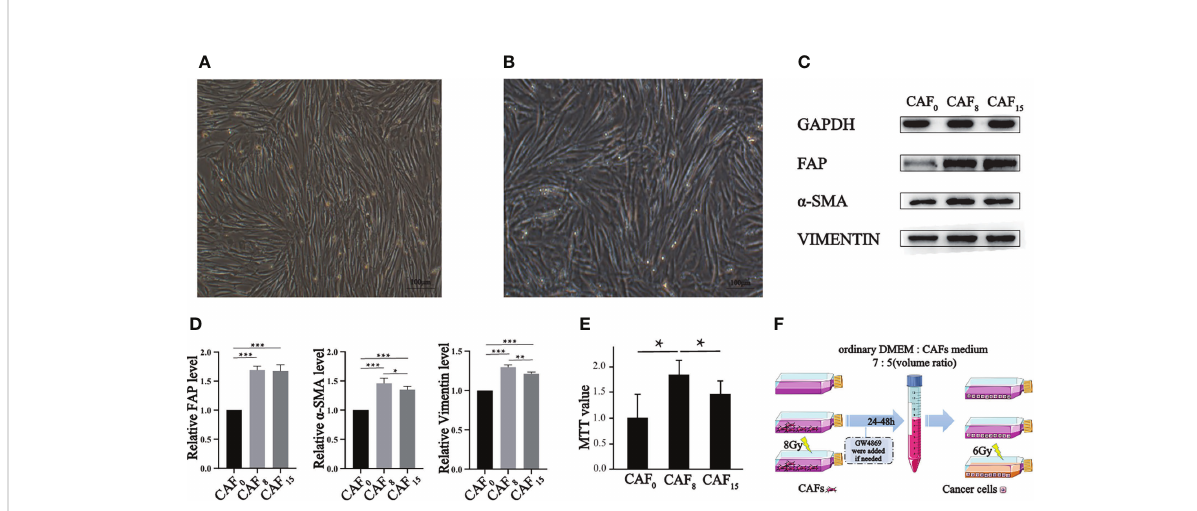
FIGURE 1 Effect of irradiation on the morphology, molecular markers, and proliferation of CAFs. (A, B) Morphology of CAFs without irradiation (A) and CAFs that received 8Gy irradiation (B) were compared under a light microscope (100×), and both groups of cells were spindle-shaped, but the irradiated cells were slightly disorganized; (C) Representative western blotting for FAP, a -SMA, and vimentin in CAFs that received 0Gy, 8Gy, and 15Gy irradiation; (D) The relative expression differences of the biomarkers after normalization of the GAPDH were analyzed by quantitatively comparing the density differences of the immunoblot bands; (E) MTT experiment was used to analyze the proliferation activity of CAFs under 0Gy, 8Gy, and 15Gy irradiation. T-test, * P < 0.05; (F) The sketch map of supernatants preparations of CAFs. (T-test, data are presented as the mean ± S.D. *P < 0.05, **P < 0.01, ***P <